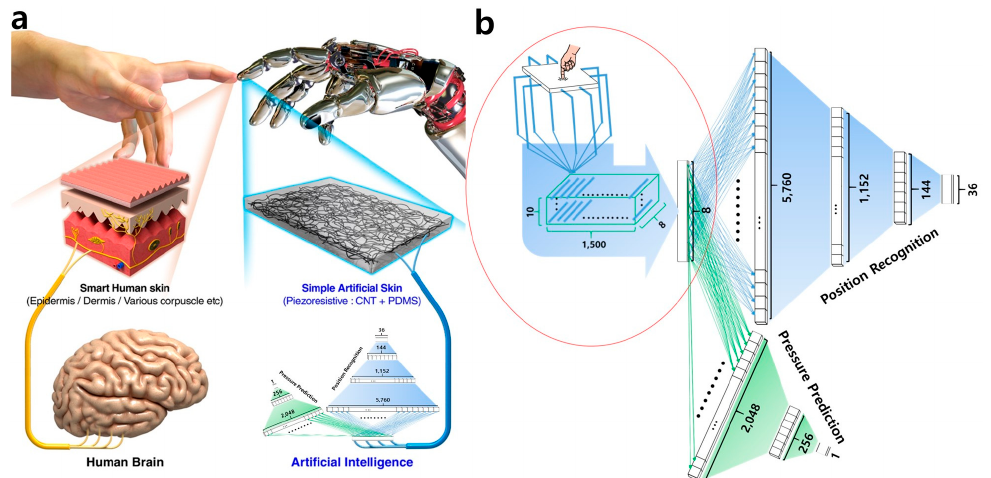
Figure 4. An illustrative study in [149] showing the basic concept for artificial skin and a DNN architecture for reliable sensing: ( a ) a schematic elucidating the comparison between the human skin and the artificial skin; and ( b ) the DNN architecture for tactile sensing. (Reprinted with permission from the authors [149] under the terms and conditions of the Creative Commons Attribution license (http://creativecommons.org/licenses/by/4.0/)). Table 5. Some existing smart tactile sensing systems and the related machine learning techniques. Reference